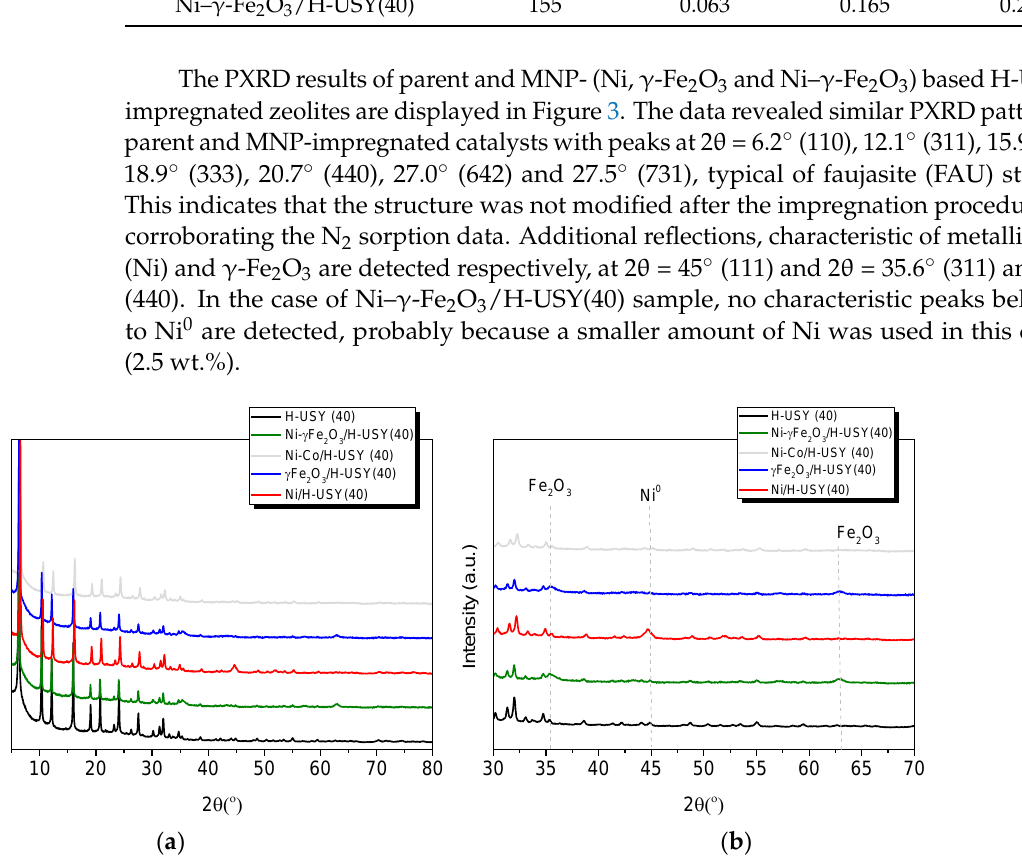
Figure 3. ( a ) XRD patterns of parent and MNPs impregnated H-USY(40) zeolites; ( b ) Magnification.